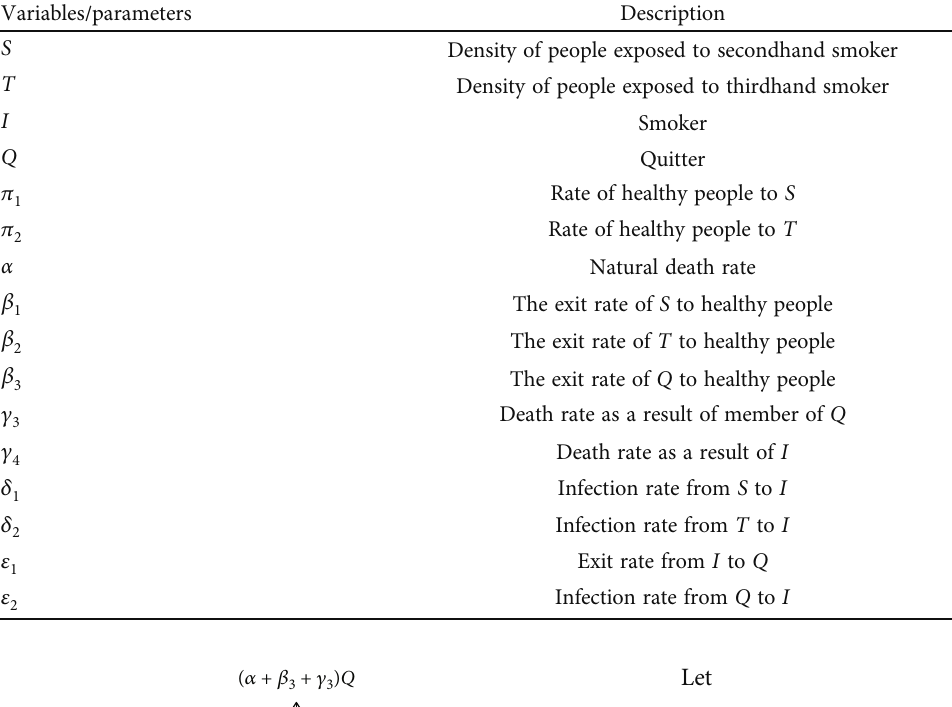
Table 1: Description of variables and parameters.